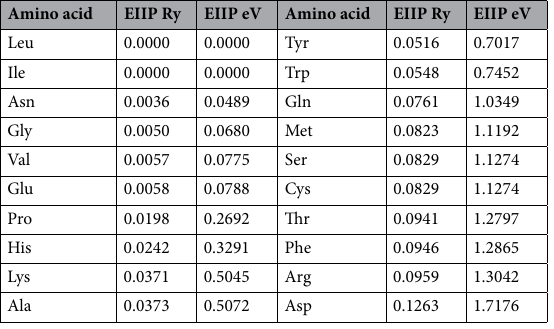
Table 1. Electron–ion interaction potential (EIIP) value for amino acids. From 15, 16